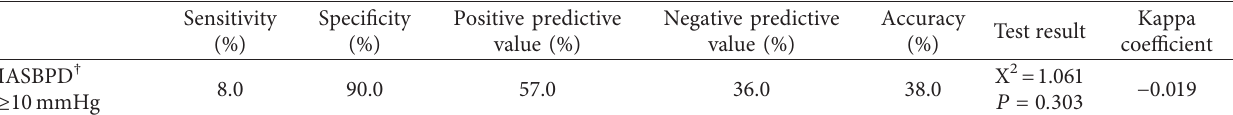
Table 4: The sensitivity and specificity of the IASBPD ≥ 10mmHg index to detect the presence of coronary artery diseases. Sensitivity